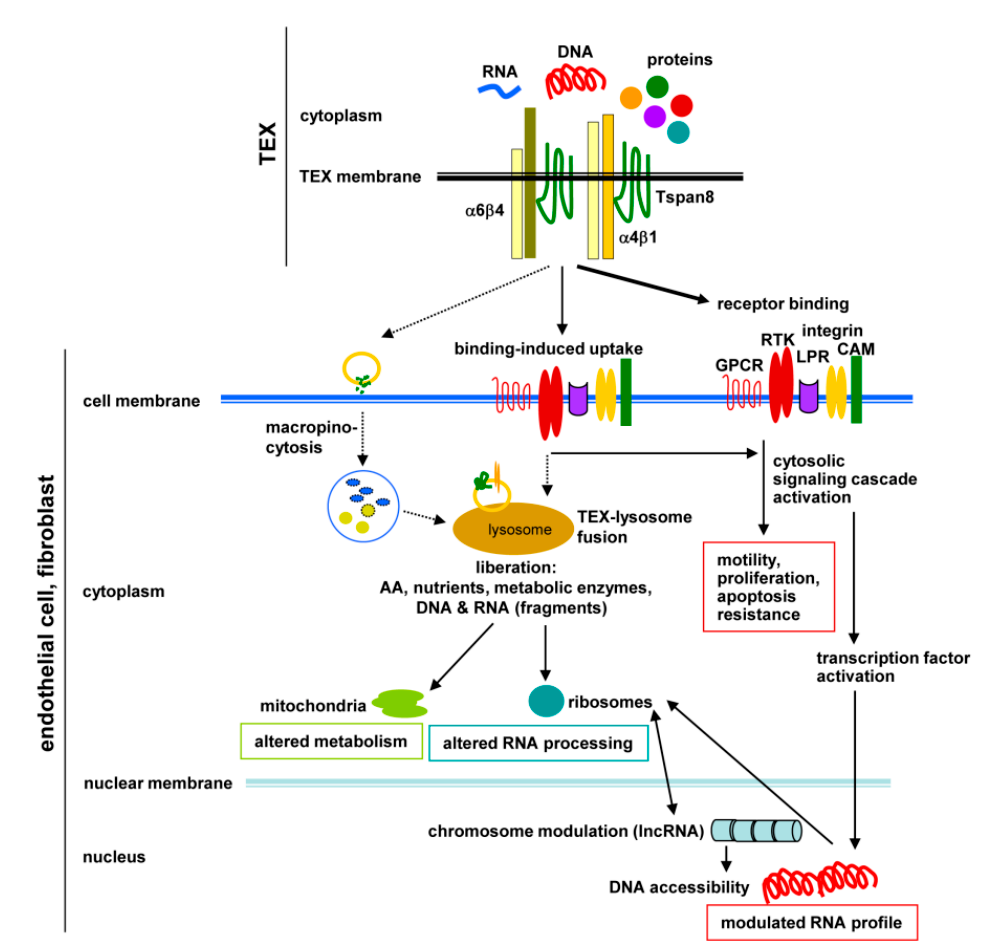
Figure 8. Coordinated view of Tspan8-TEX-initiated non-transformed cell remodeling. Tspan8-TEX